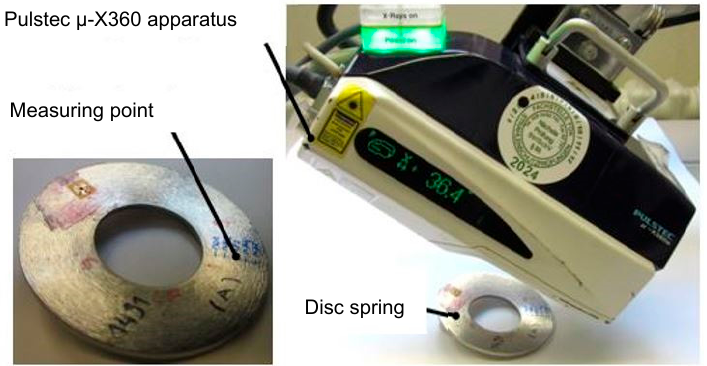
Figure 4. Experimental setup for the measurement of the residual stresses in disc springs by portable residual stress analyzer.